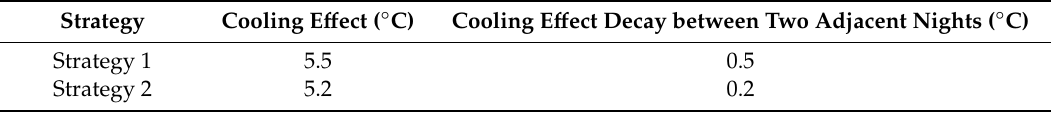
Table 6. Outlet temperature performance under two strategies.